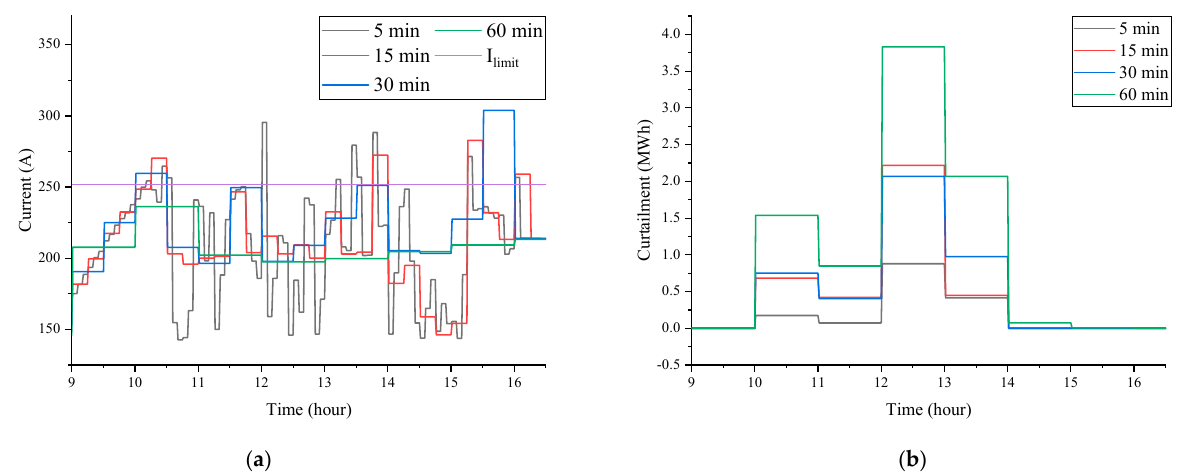
Figure 18. Maximum current and curtailment with respect to the control period on Day 33: ( a ) maximum current before control; ( b ) curtailment.